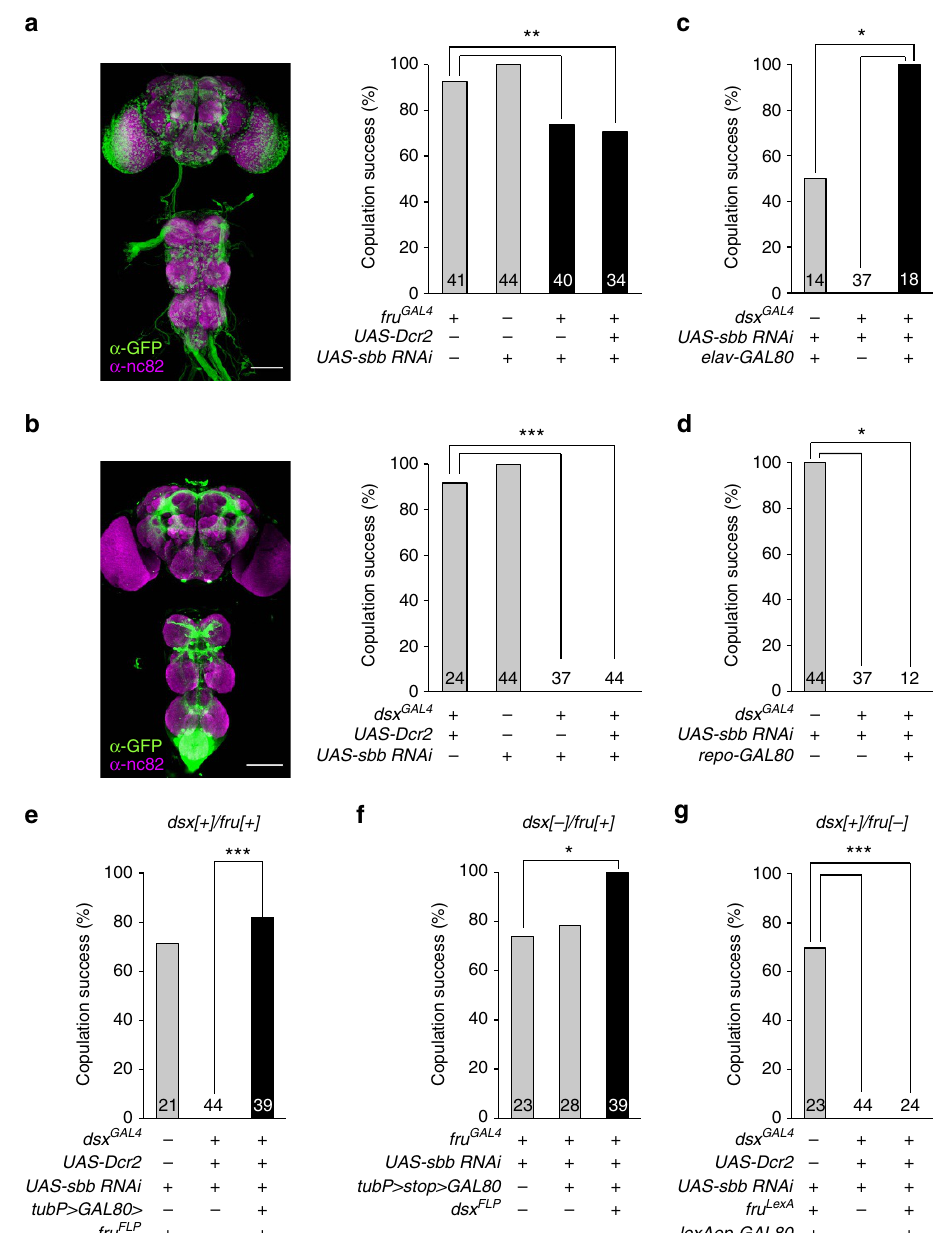
Figure 2 | Contribution of neurons positive for fru and/or dsx and of glia to the copulation defect in flies with sbb knockdown. Images (left-side panels) of the CNS with fru -positive ( a ) or dsx -positive ( b ) neurons and the effect of sbb knockdown in the respective neurons (right-side panels) on the copulation rate. The genotypes of flies for the histological analysis are w; UAS-mCD8::GFP/ þ ; fru GAL4 / þ ( a ) and w; UAS-mCD8::GFP/ þ ; dsx GAL4 / þ ( b ), respectively. Scale bar, 100 m m. ( c , d ) Effect of neuron-excluded ( c ) or glia-excluded (d) sbb knockdown on copulation. ( e – g ) Effect of sbb knockdown in dsx [ þ ]/ fru [ þ ] ( e ), dsx [ (cid:2) ]/ fru [ þ ] ( f ) or dsx [ þ ]/ fru [ (cid:2) ] ( g ) on copulation. * P o 0.05; ** P o 0.01; *** P o 0.001 by the w 2 -test. Data are presented as described in the legend of Fig.